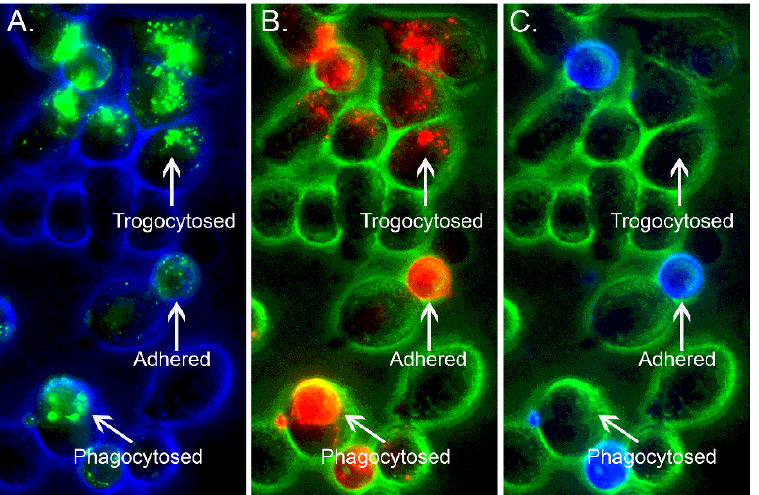
Figure 2. Phagocytosis and trogocytosis are demonstrable in the same timeframe. Mouse 38C13 B cells expressing human CD20 were dyed with PKH26 (( B ), red) and then opsonized with Al488 rituximab (( A ), green). The cells were then reacted with adhered J774 macrophages for 30 min and finally stained with Al647 anti-mouse IgM (( C ), blue). Based on the staining patterns, it is possible to identify adhered cells (blue, red, and green), phagocytosed cells (red and green, but no blue staining), and portions of trogocytosed cells (fragments of only red and green) [38,54]. Adapted with permission from Ref. [38], 2010, The American Association of Immunologists, Inc.